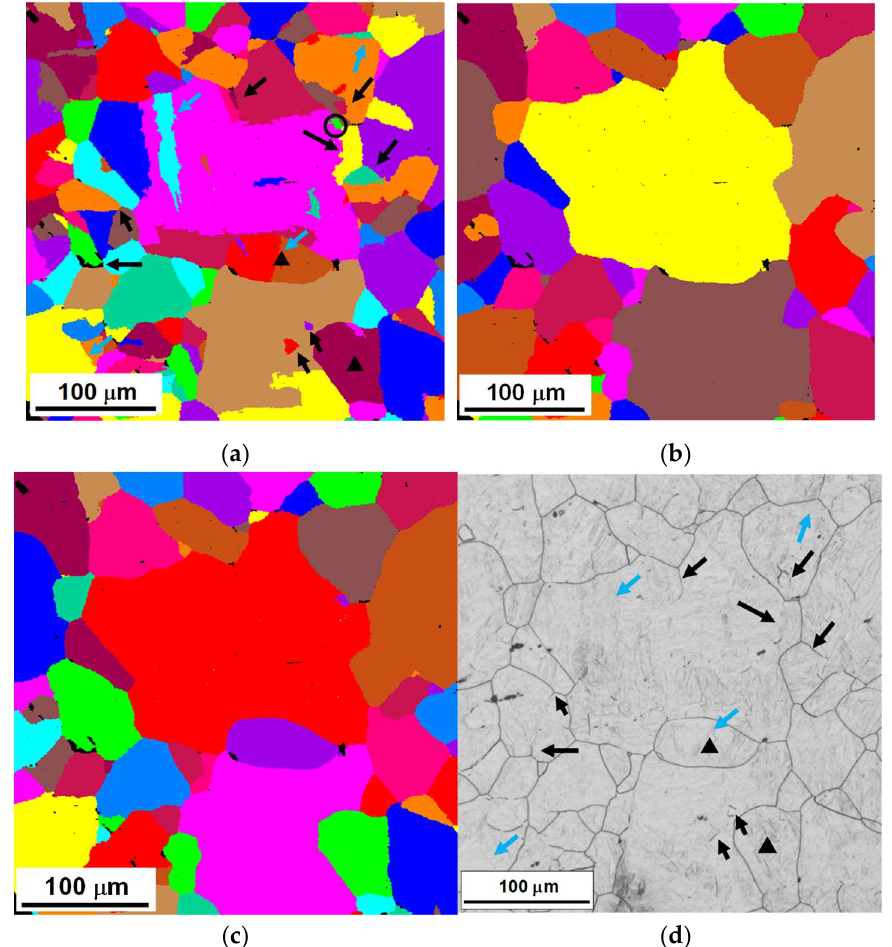
Figure 7. Unique grain color maps obtained for the austenite phase from the results of the reconstruction applied to the martensitic scan data in Figure 2a (Step size = 0.5 μm) using a tolerance angle for a grain boundary definition of 10° and different criteria for twin boundary exclusion: ( a ) All high angle grain (>10°) boundaries considered; ( b ) twins excluded (misorientation criterion (5° tolerance)); ( c ) twins excluded (misorientation criterion (5° tolerance) + {111} plane coincidence criterion (1° tolerance angle)) and ( d ) optical micrograph. Black areas correspond to non-reconstructed regions. In ( a , d ) black arrows mark boundaries which are present in ( a ) but not in ( b ) and/or ( c ), and which appear faintly or do not close to define grains in the optical micrograph in ( d ); blue arrows mark twins which are not revealed in the optical micrograph in ( d ); triangles mark grains that can be observed in ( c , d ) but not in ( b ).